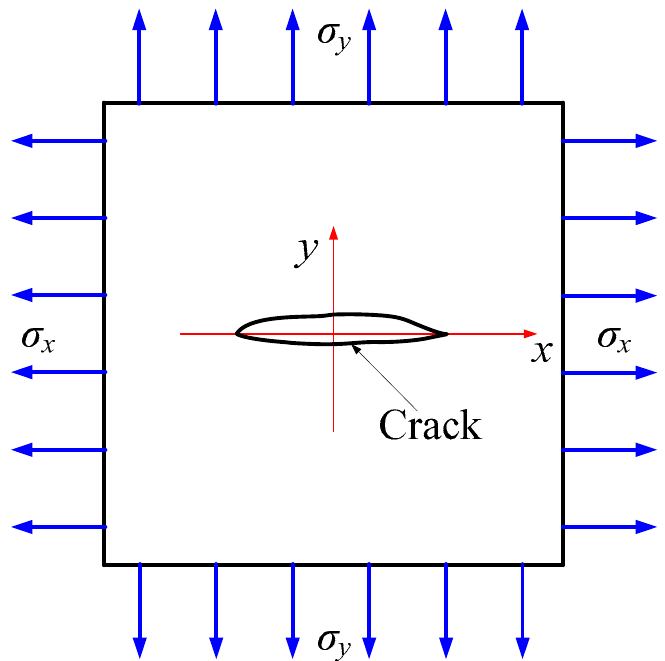
Figure 13. K TH as a function of the hydrogen concentration C in AerMet100 [40].